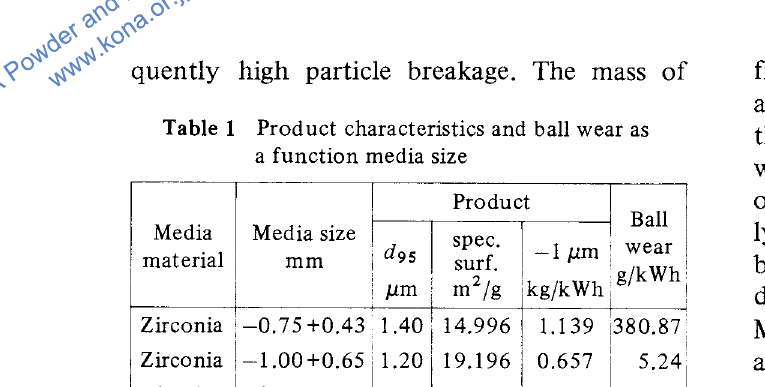
Table 1 Product characteristics and ball wear as